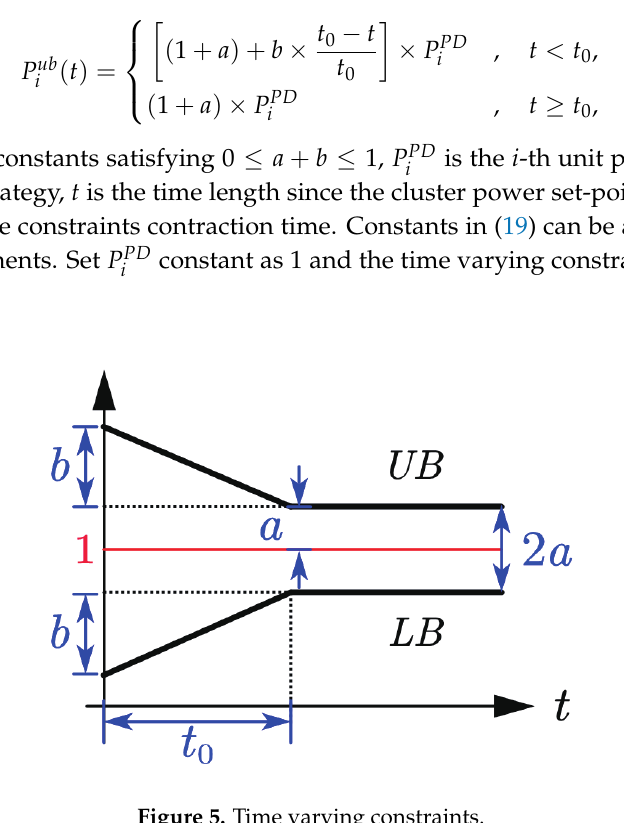
Figure 5. Time varying